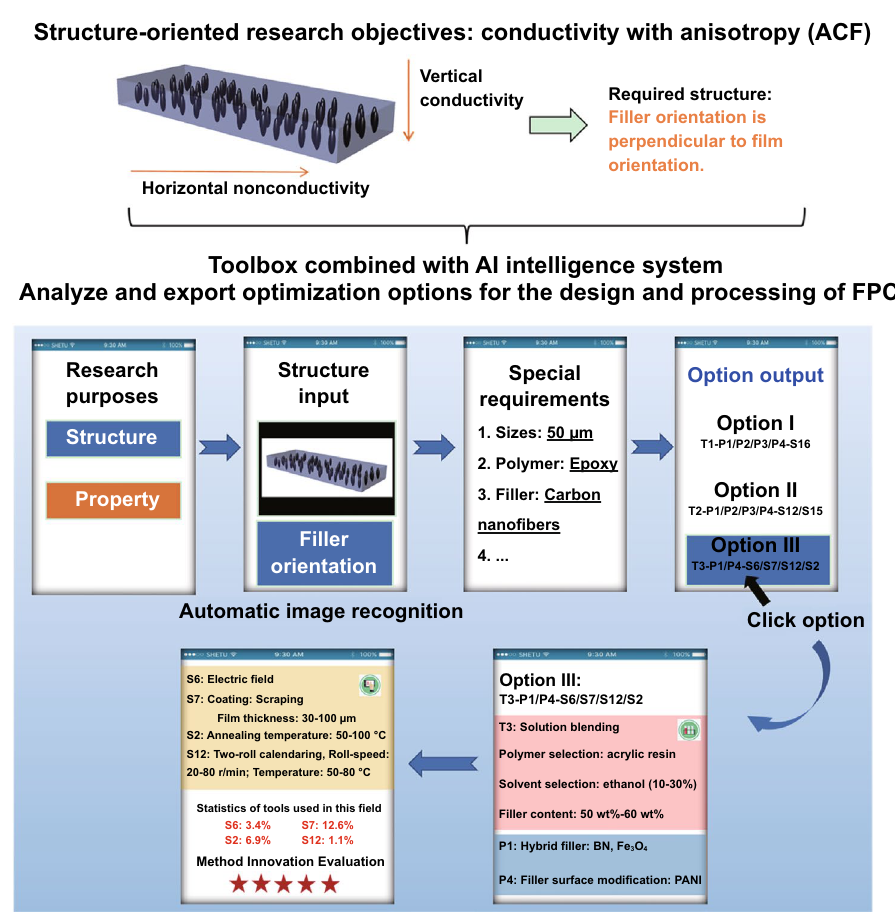
Fig. 15 Demonstration of the application for morphological control “Toolbox” in combination with artificial